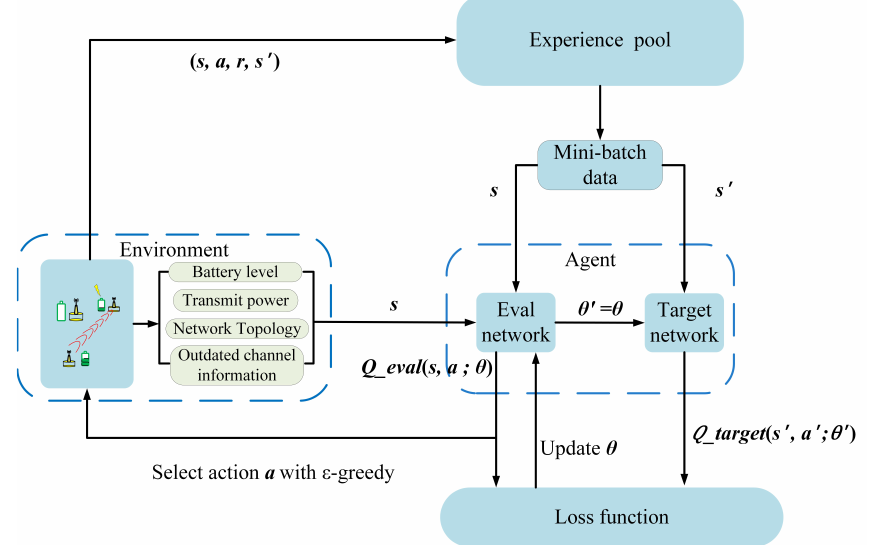
Figure 3. Framework of joint resource allocation based deep Q network algorithm considering energy harvesting (JADQ-EH)